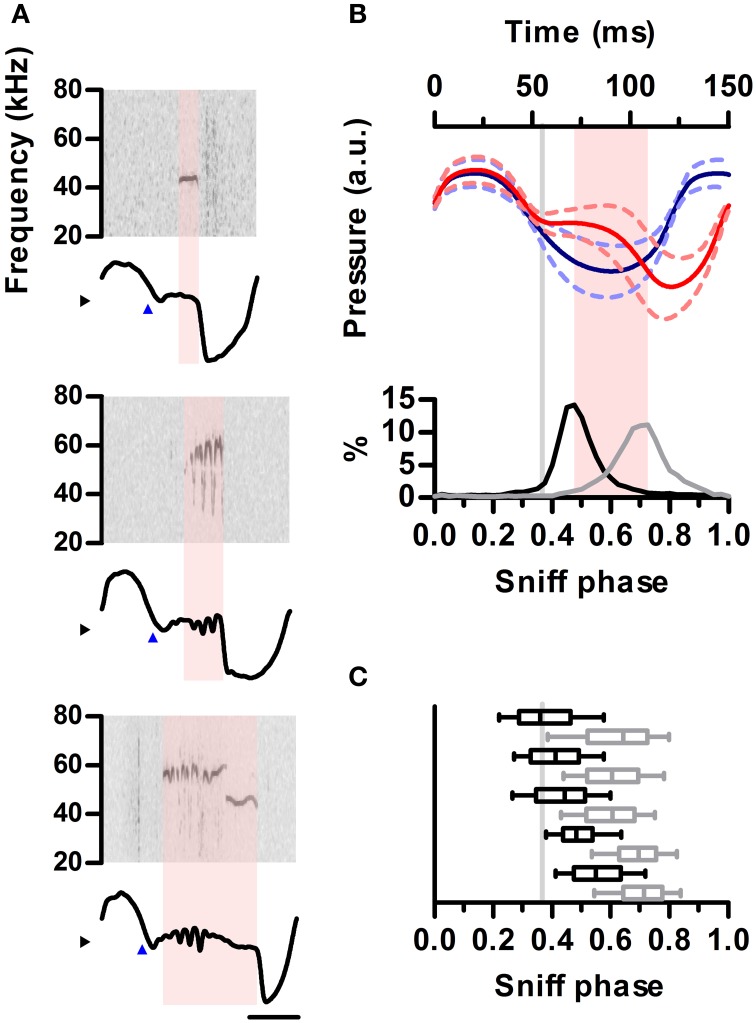
Ultrasound emission is restricted to specific phases of the sniff cycle. (A) Spectrograms from 3 ultrasound emissions (top) aligned to their corresponding intranasal pressure traces (bottom). Blue arrowheads mark exhalation onset. Note ultrasound is produced during low-pressure region following exhalation onset. (B) Top: mean sniff waveforms from silent (blue) or vocal (red) sniffs for one example rat. All waveforms were warped to align at three points: onsets of inhalation and exhalation and the end of exhalation. Bottom: distribution of ultrasound onset (black) and offset (gray) phases in the vocal sniffs. Inhalation onset: phase = 0, exhalation onset: phase = 0.33, end of exhalation: phase = 1. Gray line: exhalation onset. Time between most frequent vocalization onset and offset marked in pink. (C) Distribution of ultrasound onset (black) and offset (gray) phases for all rats. Boxes: median and 25–75th percentiles. Whiskers: 10–90th percentiles.